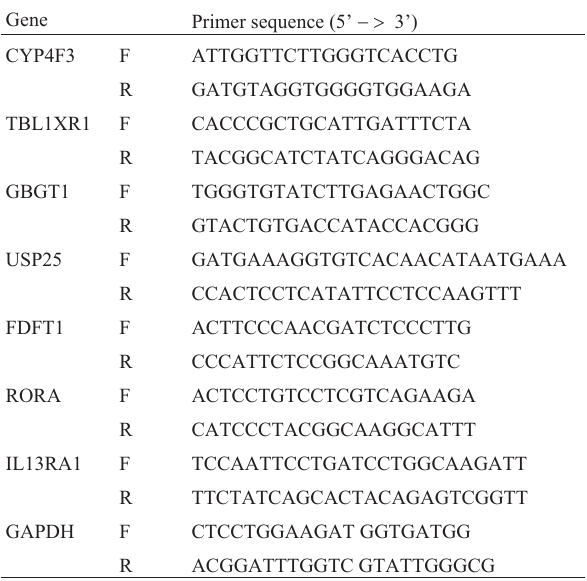
Table1 -Baselineinformationofthestudysubjectsformicroarrayassay. Parameters